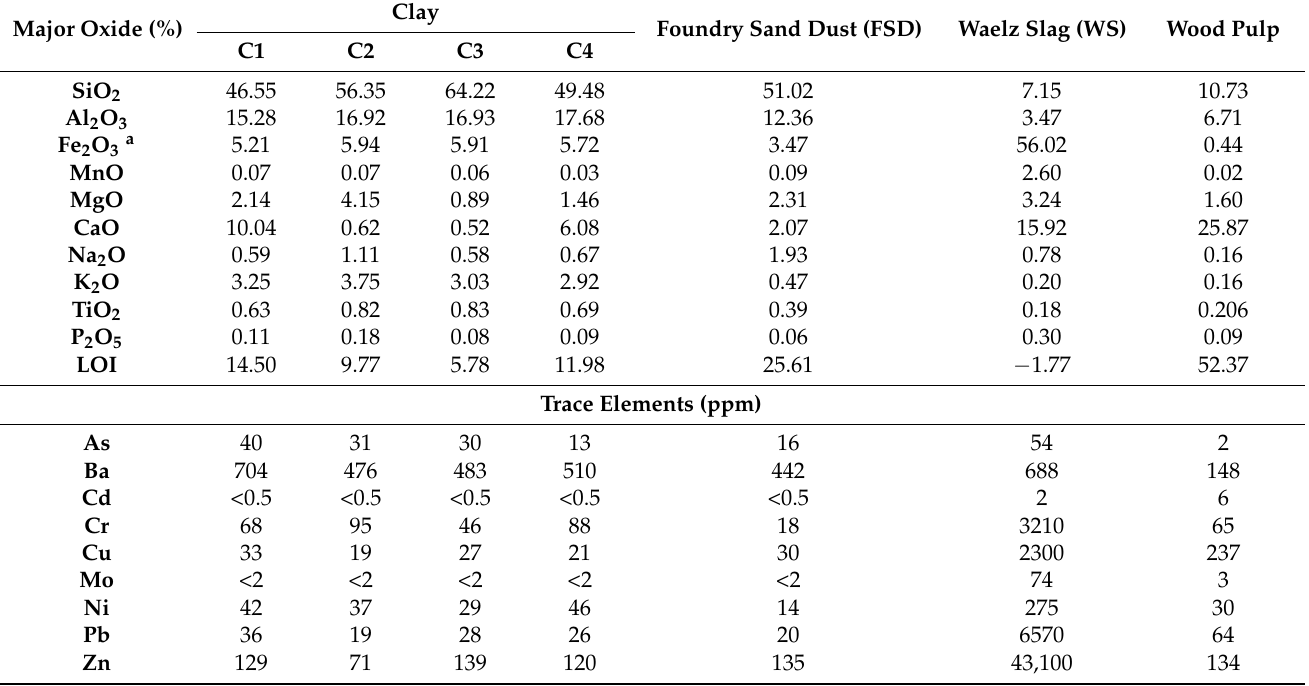
Table 1. Major oxide and trace elements concentrations of the raw materials employed in the manufacture of the ceramic products. Clay Major Oxide (%) Foundry Sand Dust (FSD) Waelz Slag (WS)